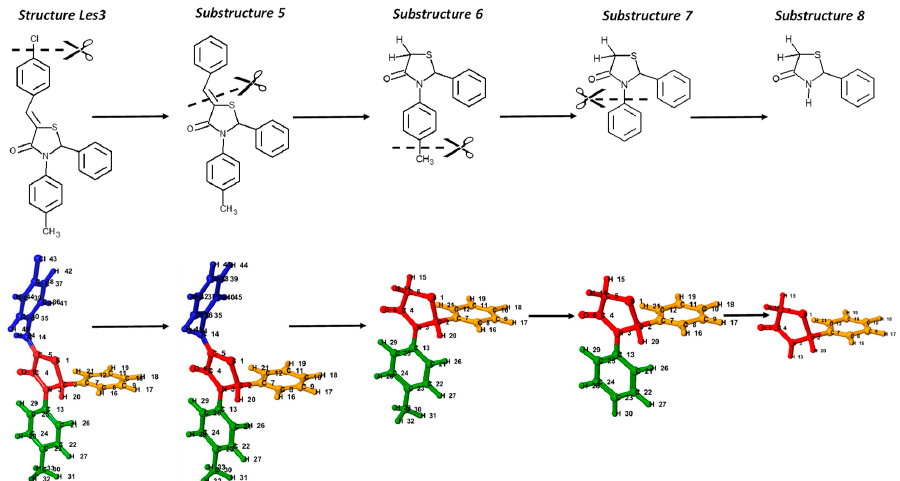
Figure 10. The cutting scheme of the molecule Les3 (Les-3201). The bottom row shows the numbering of atoms and color codes of common core ( Φ —red) and substituents (R1—orange, R2—green, and R4—blue).